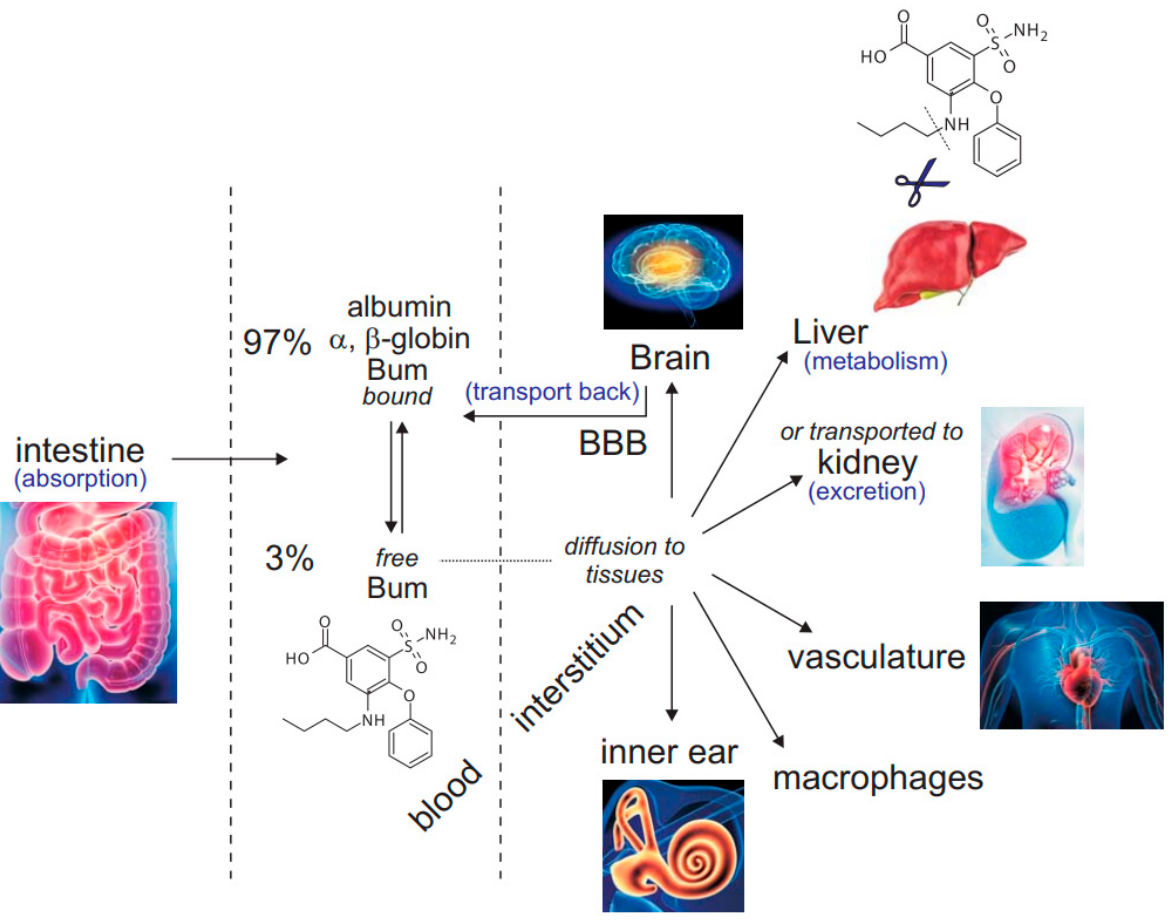
Figure 1. Bumetanide after oral administration. Once absorbed by the intestine, the inhibitor exists in equilibrium as free (3%) versus protein-bound bumetanide (97%). From the blood compartment, bumetanide is transported to the kidney nephrons by specialized transporters where it acts in the pro-urine on the thick ascending limb of Henle to inhibit NKCC2-mediated Na + reabsorption. It is then excreted into the bladder. Bumetanide also diffuses to other tissues where it can act as an NKCC1 inhibitor, provided that its concentration in the periphery reaches values high enough to affect the cotransporter. This includes vasculature, immune cells, inner ear, etc. In the liver, bumetanide is cleaved and metabolized. Because the molecule is rather hydrophobic, it likely crosses the blood-brain barrier (BBB) but is likely transported back to the blood